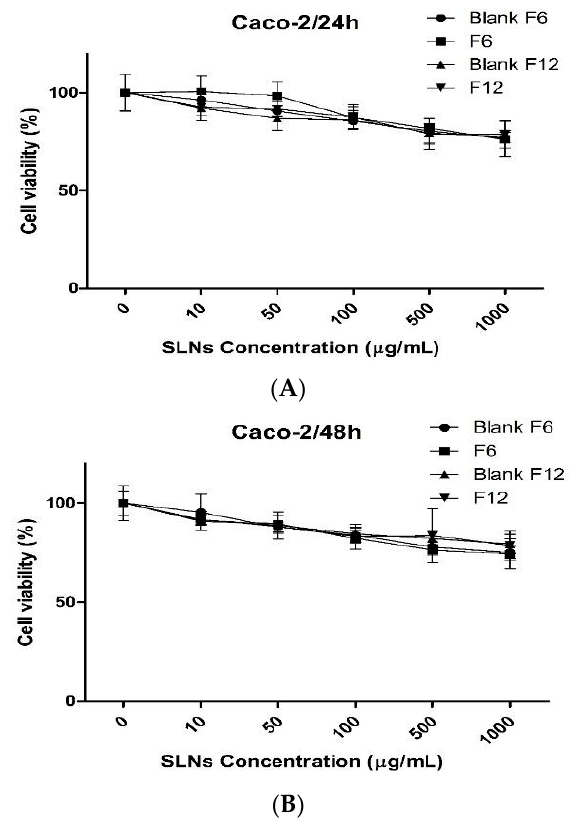
Figure 6. Cell viability of Caco-2 cells treated with blank F6, F6, blank F12 and F12 for ( A ) 24 and ( B ) 48 h ( n = 3).